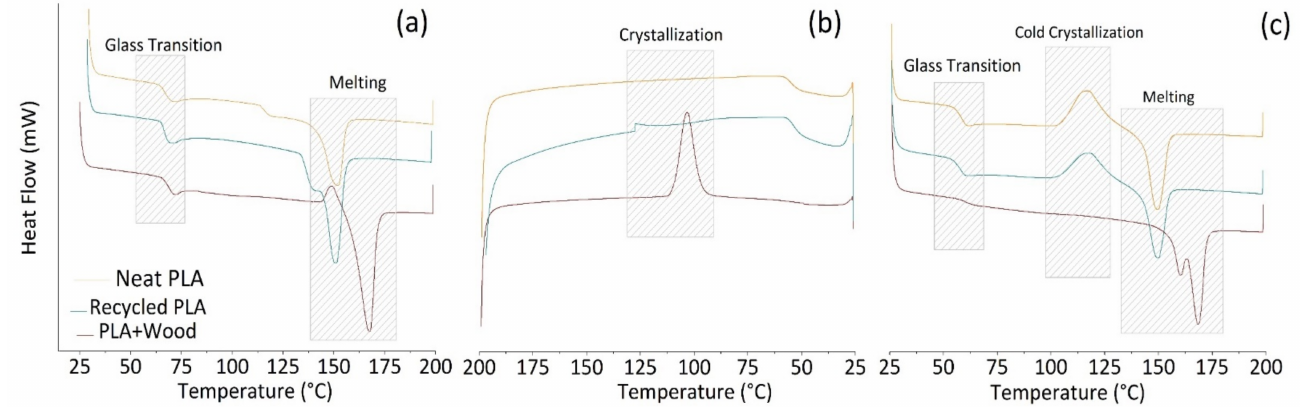
Figure 3. Heat flow vs. temperature recorded during thermal cycles of DSC analyses for the investigated samples: ( a ) first heating; ( b ) cooling; ( c ) second